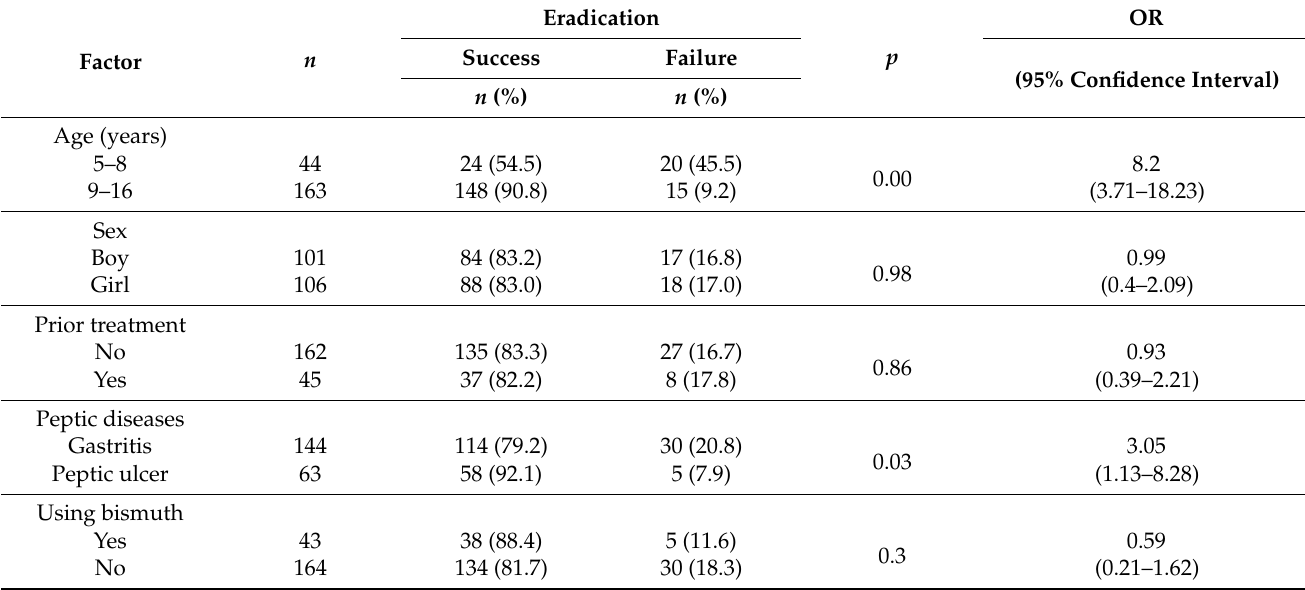
Table 5. Helicobacter pylori eradication rate of tailored therapy and associated factors ( n =